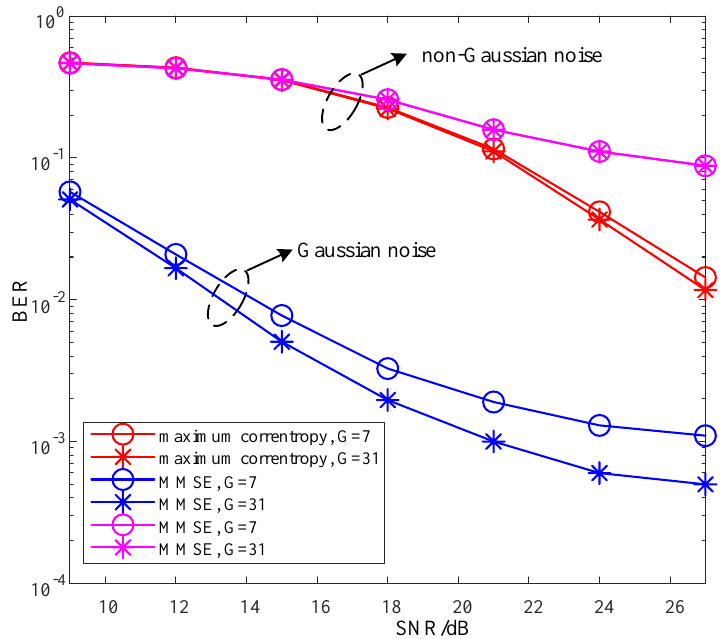
Figure 5. BER comparisons of the proposed SC-MMSE detectors for the GSTFIM systems with N t = 2 and N r = 2 under Gaussian noise and non-Gaussian noise.